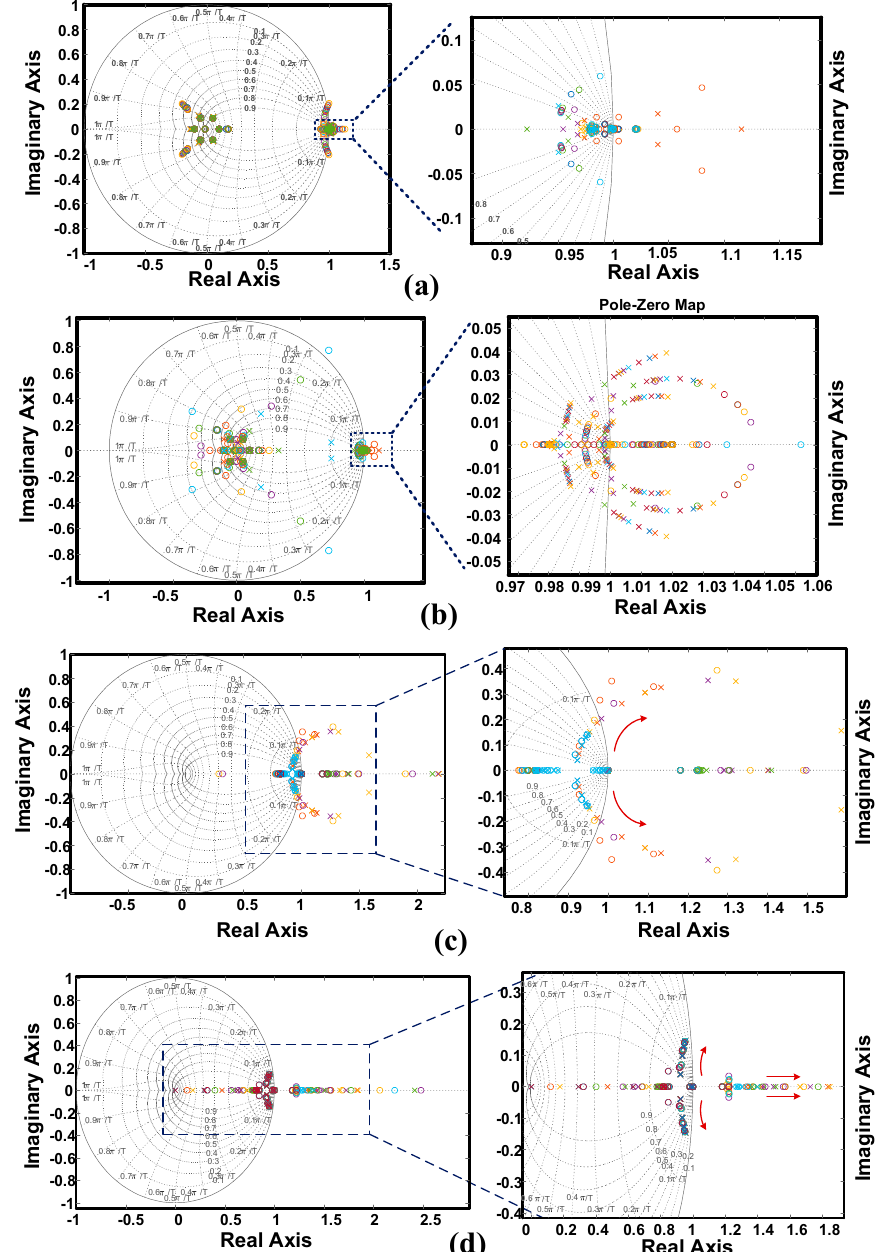
Figure 5. Pole zero plots: ( a ) Effect of m Pi variation with distributed proposed power estimators ( b ) Effect of n Qi variation with proposed power estimators ( c ) Effect of m Pi variation with consensus-based observer ( d ) Effect of n Qi variation with consensus-based observer. Table 3. Variation Range for Controller Parameters.